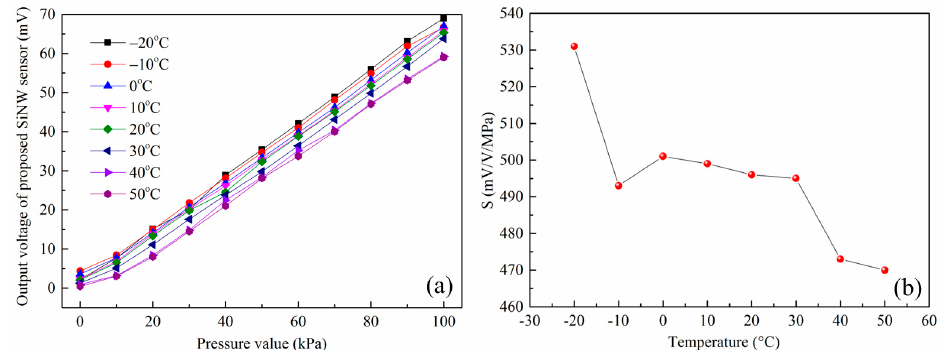
Figure 11. ( a ) Dependence of the output voltages of SOI pressure sensor without compensation on the pressure with temperature from − 20 to 50 °C; and ( b ) the relationship curve between the sensitivity and temperature.